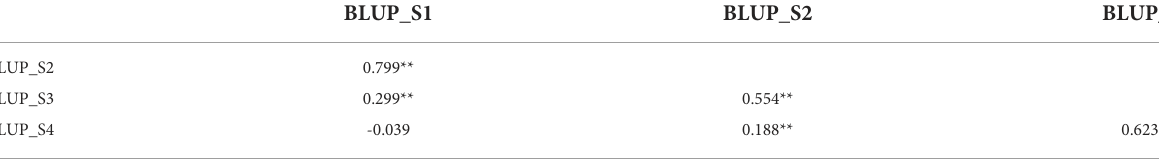
TABLE 2 Correlation coef fi cients of chlorophyll content between four stages of BLUP